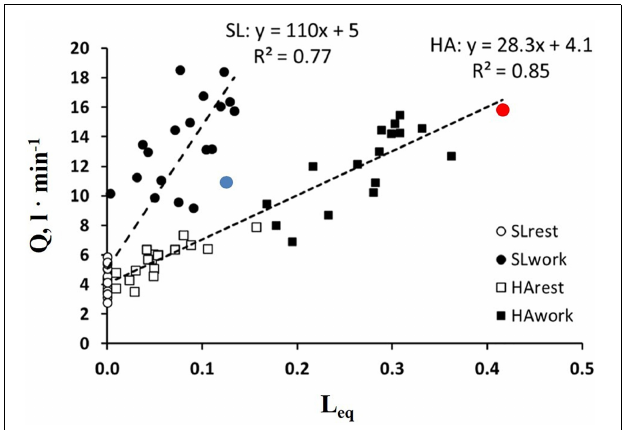
FIGURE 8 | Distribution of Leq values in all subjects at the end of exercise in severe hypoxia (HA) (3,840 m, P I O 2 90 mmHg). Red and blue dots refer to the two subjects shown in Figures 5A,B , respectively (data from Beretta et al., 2019).